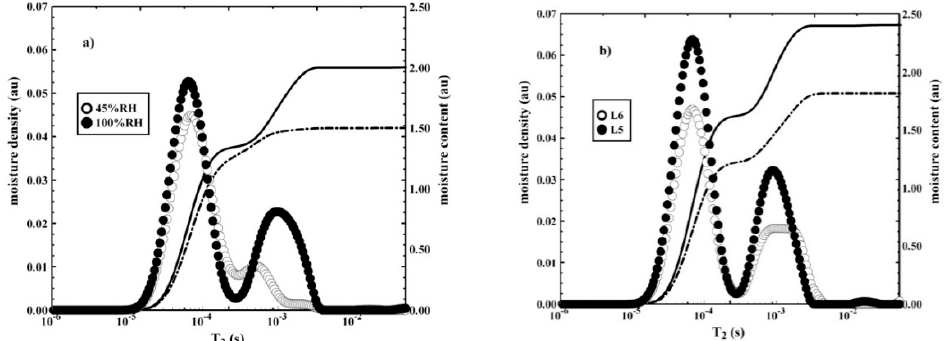
Figure 4. 1 H-NMR T 2 -distributions of ( a ) L 8 -section acquired at 45% (open circles) and 100% (closed circles) RH, ( b ) L 6 -section (open circles) and L 5 -section (closed circles) acquired at 100% RH. The corresponding integrals over T 2 are also reported.